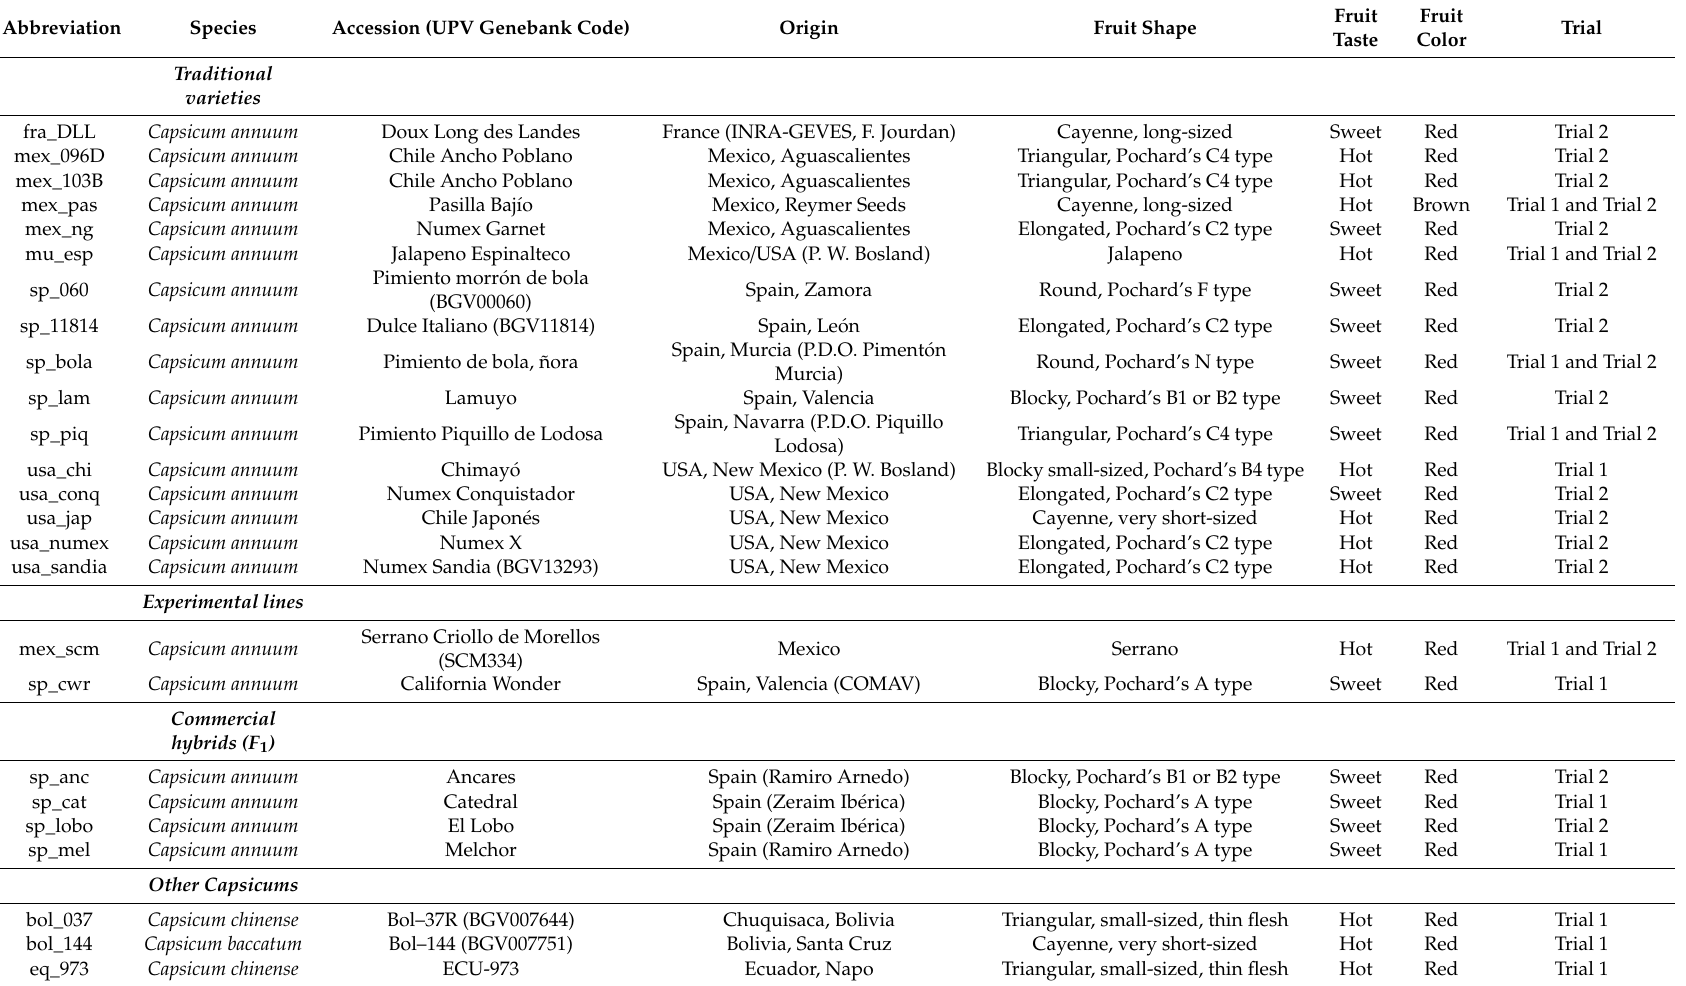
Table 1. List of the 25 accessions and corresponding abbreviation, species, varietal status, origin, fruit shape, fruit taste, fruit color and trial